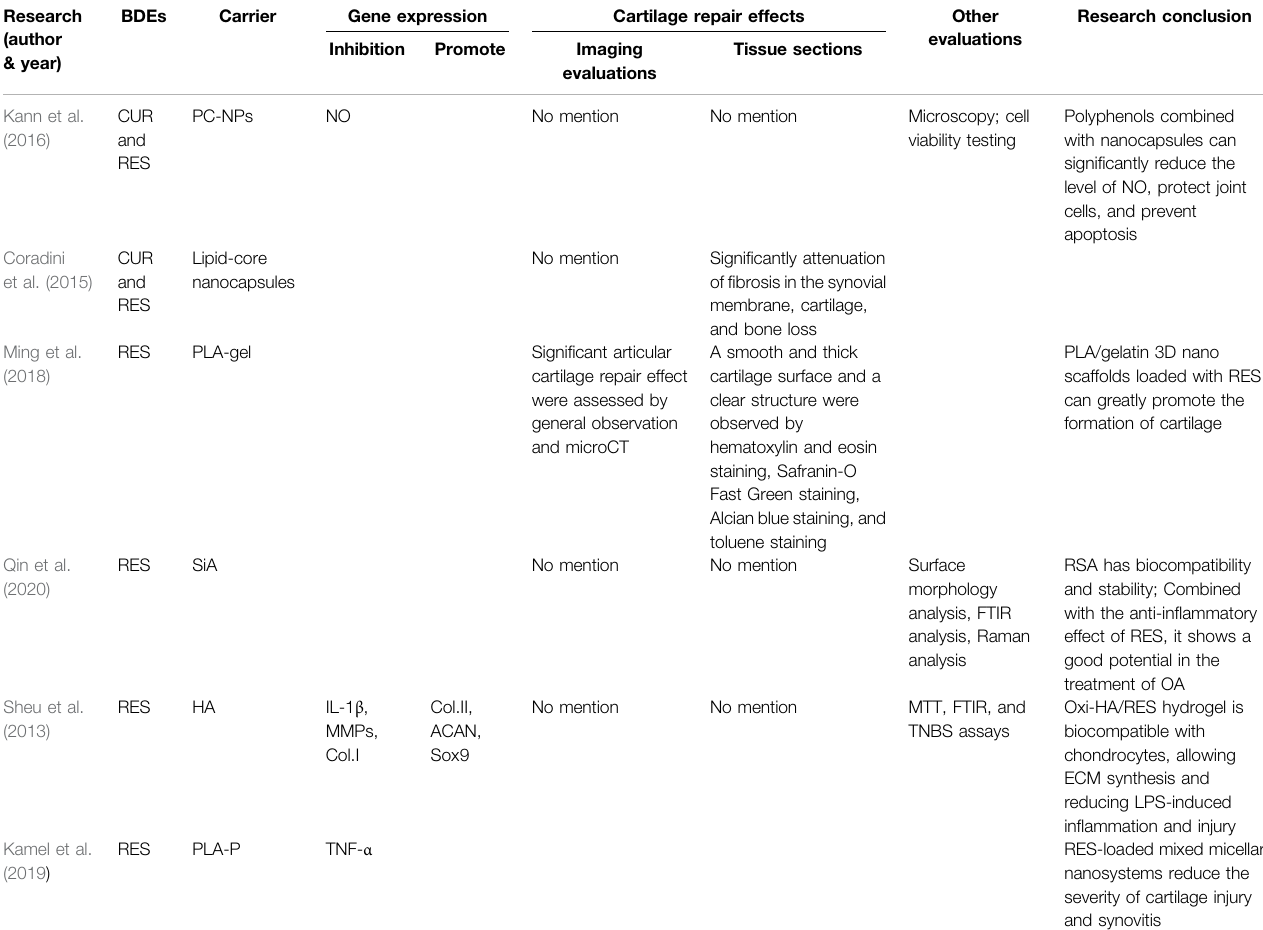
TABLE 2 | The effect of RES combined with carriers on OA cartilage